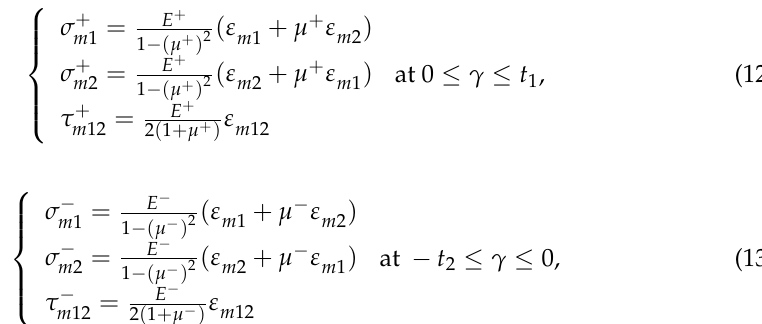
Figure 3. In-plane stress components. On the other hand, the bending and torsion deformation of the cylindrical shell must be considered under large deformation. According to the above analysis, the physical equations concerning bending stress and torsional stress will give as follows, in subareas of tension and